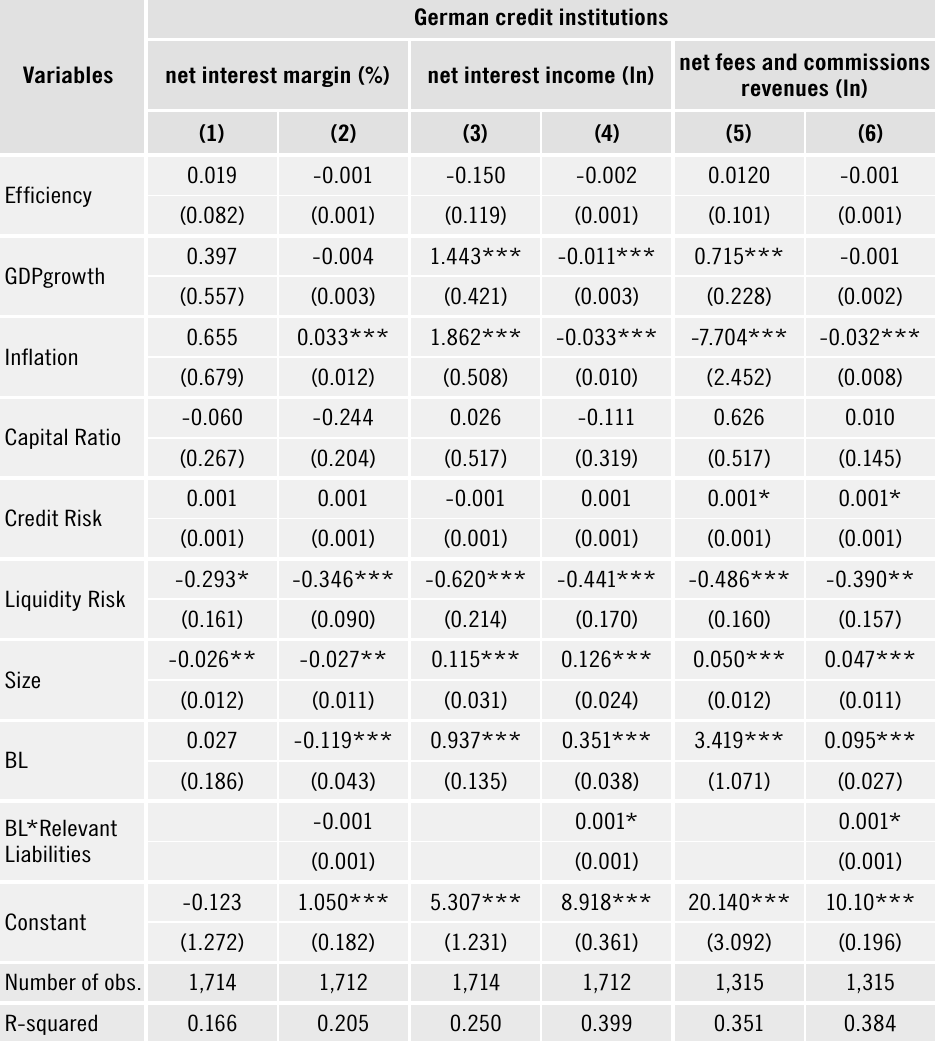
Table 8. Data presenting estimates based on GLS regressions with a random effect on German credit institutions in 2005–2015. Data have been sources from unconsolidated financial statements. Institution-specific characteristics appear as one-year lagged variables in all specifications. The bank levy (BL) is represented by a dummy variable indicating 1 for all years the levy applies to, and zero for all remaining years. Robust standard errors that control for clustering at the financial institution level are reported in